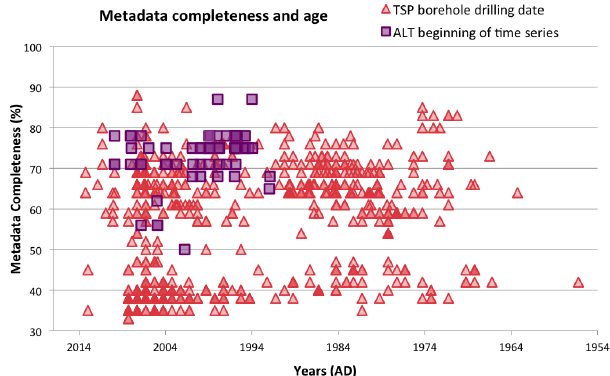
Figure 3. Metadata completeness in percent of filled-in metadata fields for TSP (1074 boreholes) and ALT (243 active layer monitor- ing sites) vs. the borehole drilling date or the first measurement of ALT time series,